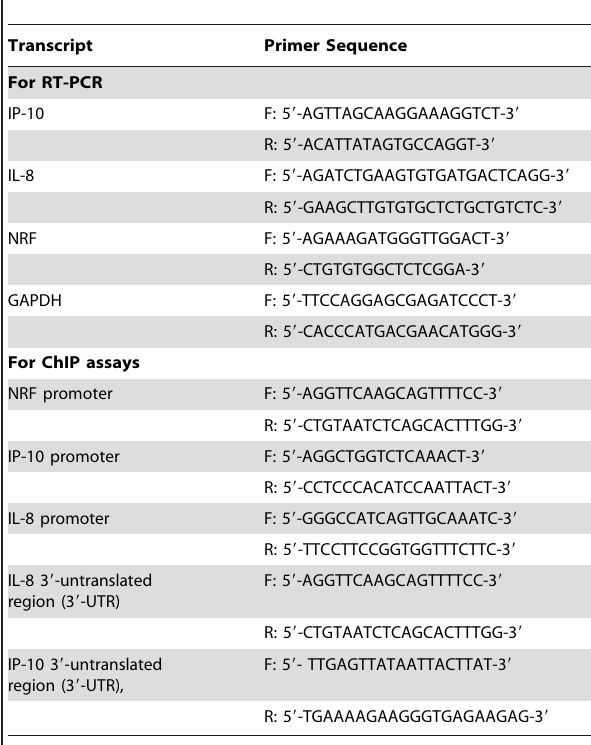
Abbreviations : F= forward; R= reverse; IP-10= Interferon gamma-induced protein-10; IL-8= interleukin-8; NRF = NF- k B repressing factor; ChIP = chromatin immunoprecipitation.